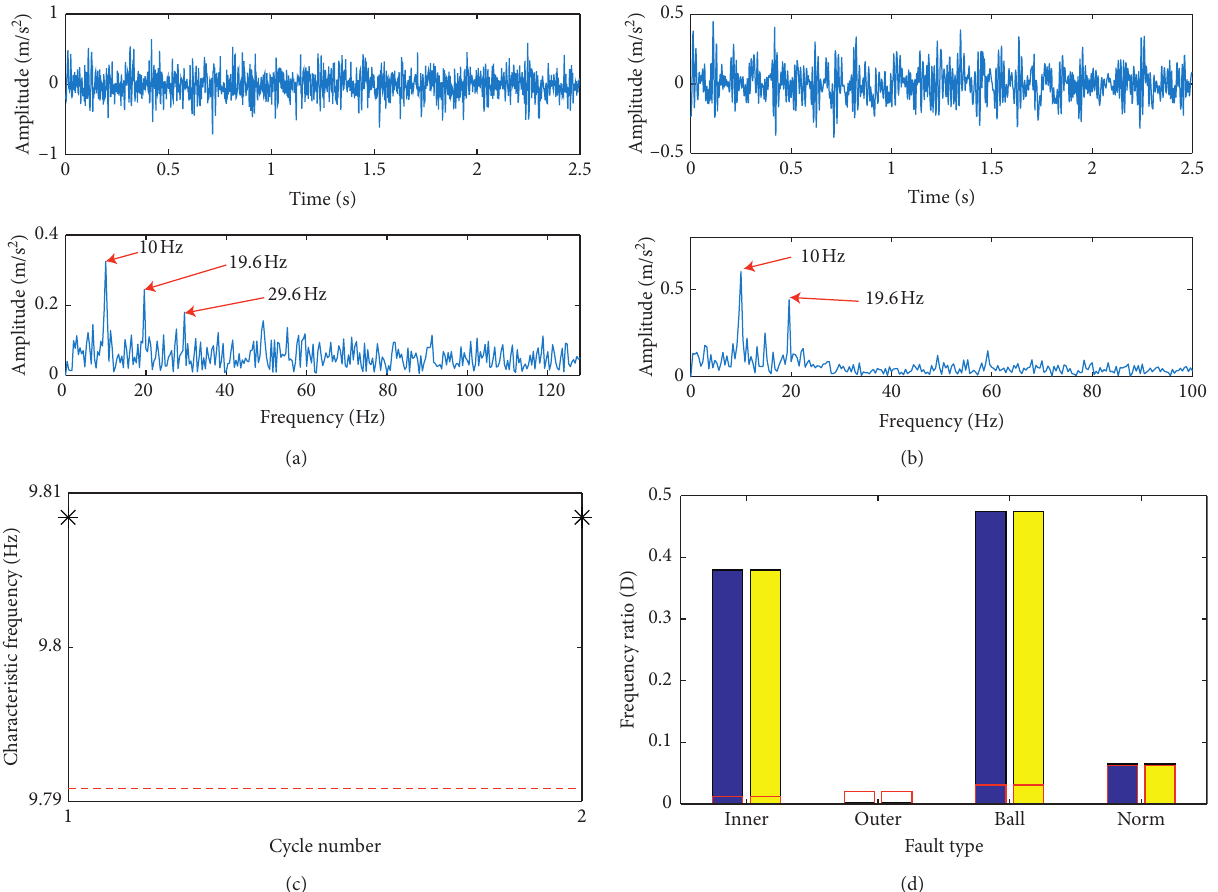
Figure 15: The diagnosis process of bearing outer ring fault: (a) the original signal; (b) the reconstructed signal; (c) characteristic frequency in each cycle; (d) the frequency ratio of fault types in each